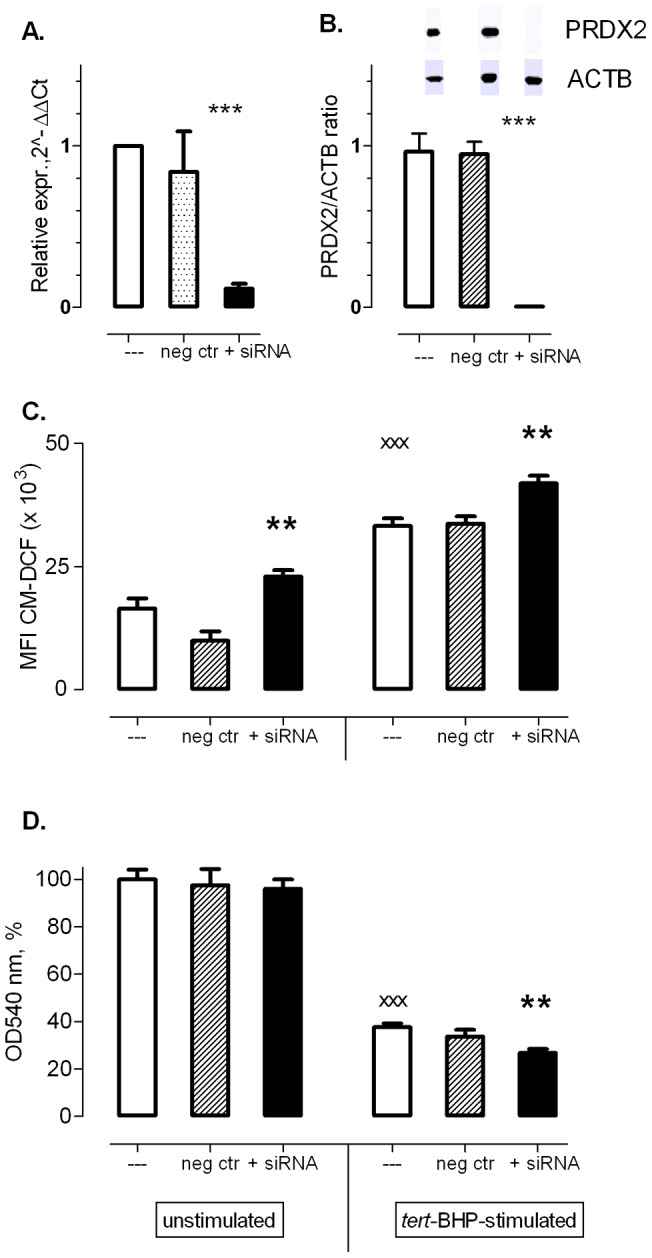
Suppression of PRDX2 mRNA and protein expression in moDCs by means of lipid-mediated siRNA transfection leads to enhanced sensitivity of moDCs to tert-BHP.
A. Reduced PRDX2 mRNA levels in unstimulated moDCs after transfection with anti-PRDX2 siRNA [qPCR; 2−ΔΔCt normalization using ACTB as reference gene and the non-transfected sample (---) as control (set to 1, n = 4)]. B. Reduction of PRDX2 protein in unstimulated moDCs monitored by Western Blot. Data were normalized using ACTB as reference gene (n = 4). C. CM-DCF fluorescence was used as index for intracellular ROS levels in non-transfected moDCs and moDCs transfected with PRDX2-targeting siRNA, with or without tert-BHP stimulation (200 μM, 30 min, n = 8). D. Neutral Red assay was used as index viability index of non-transfected moDCs and moDCs transfected with PRDX2-targeting siRNA, with or without tert-BHP stimulation (200 μM, 30 min, n = 8). **P<0.01 vs. untransfected (--) and negative control (neg. ctr), xxxP<0.001 vs. Unstimulated, paired Student's t-test (two-tailed).